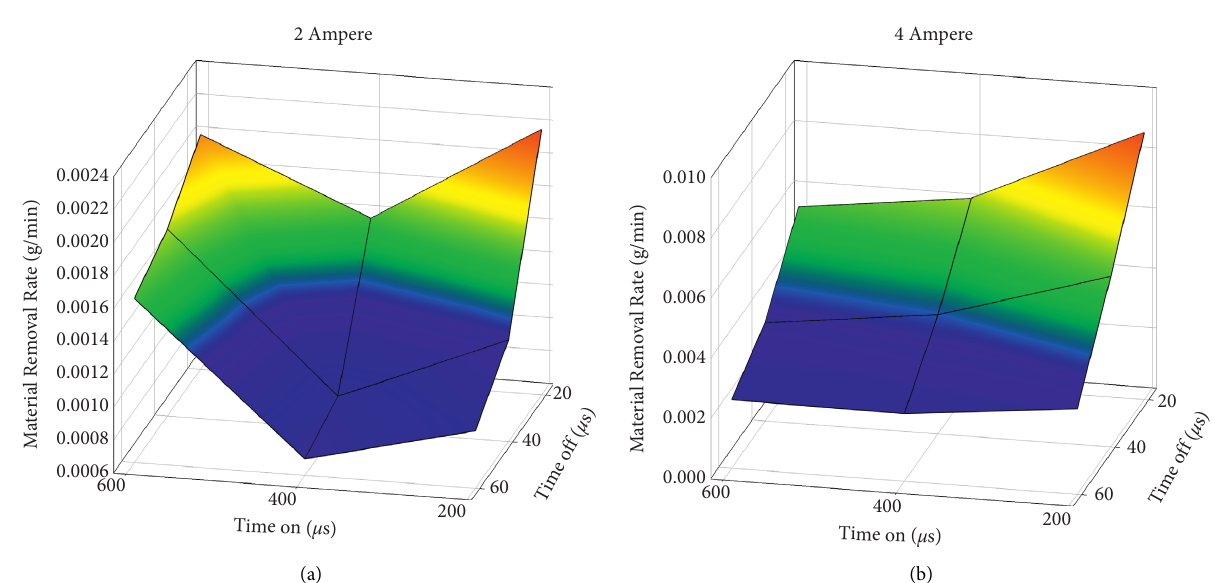
Figure 5: Effect of pulse time-on and time-off on wear rate at 2 (a) and 4 (b)